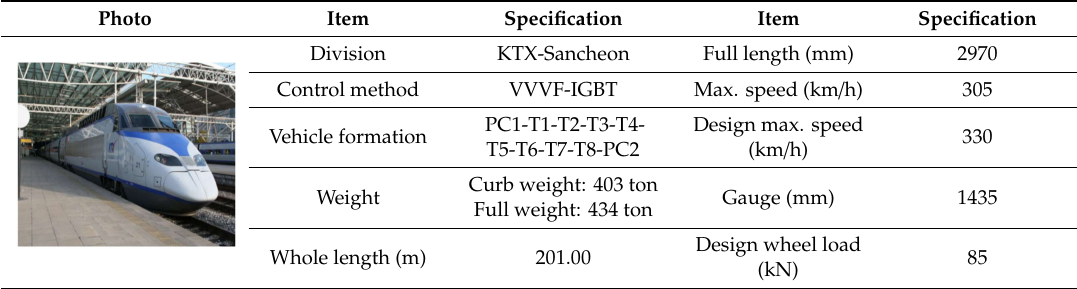
Table 4. Test train (KTX Sancheon)